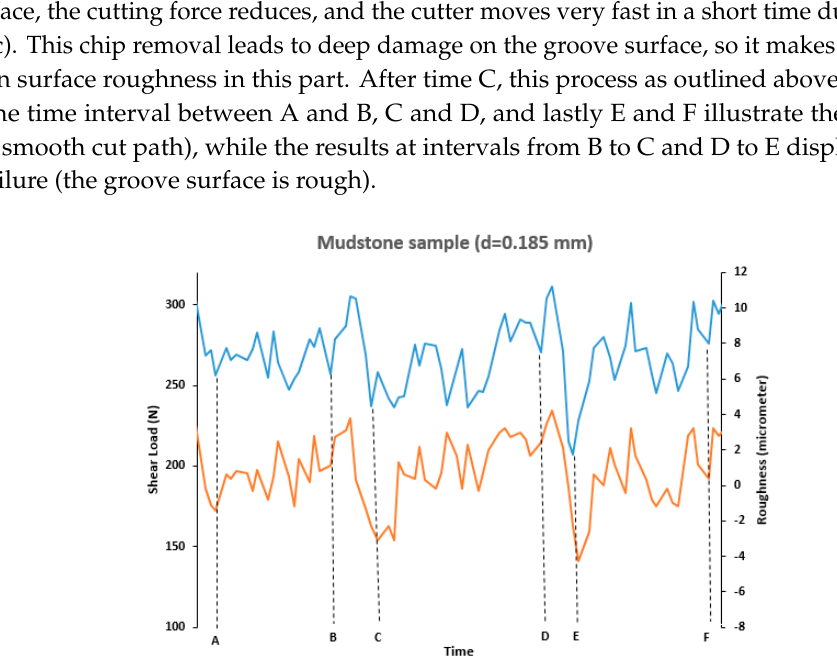
Figure 6. Variation of the shear force and the surface roughness of the mudstone rock sample during the scratch test.